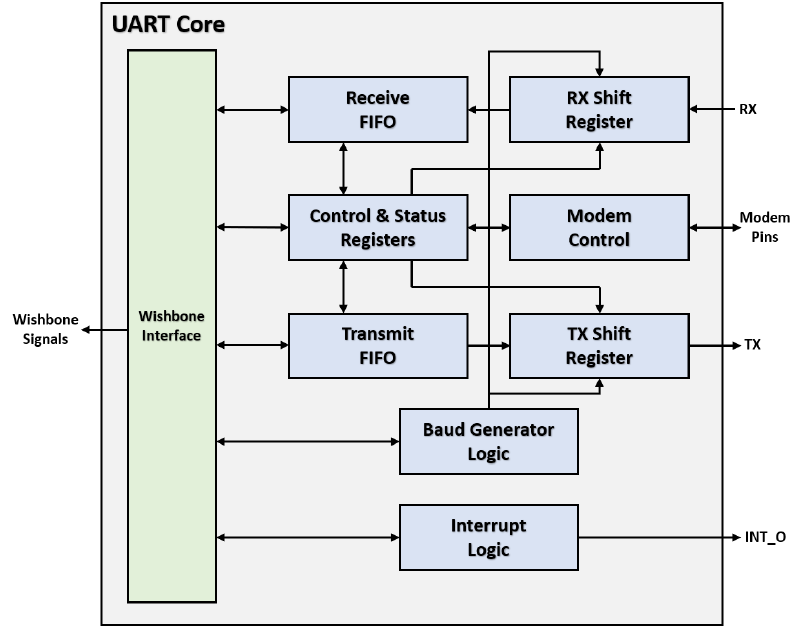
Figure 7. Block diagram of the UART